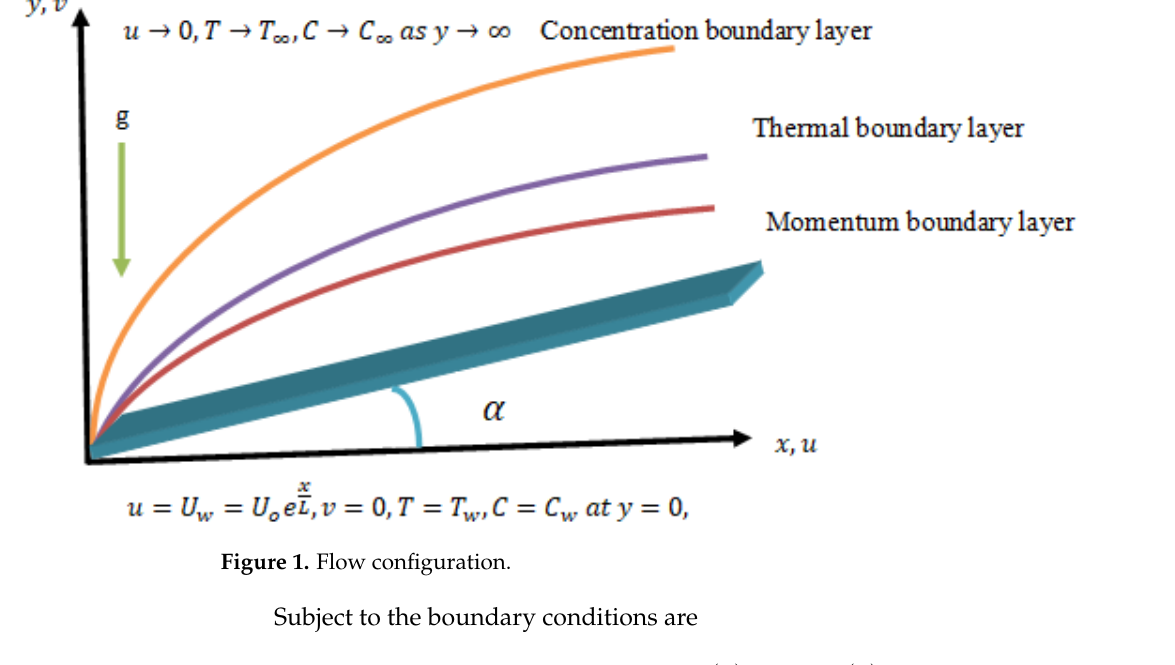
Figure 1. Flow Figure 1. Flow configuration.